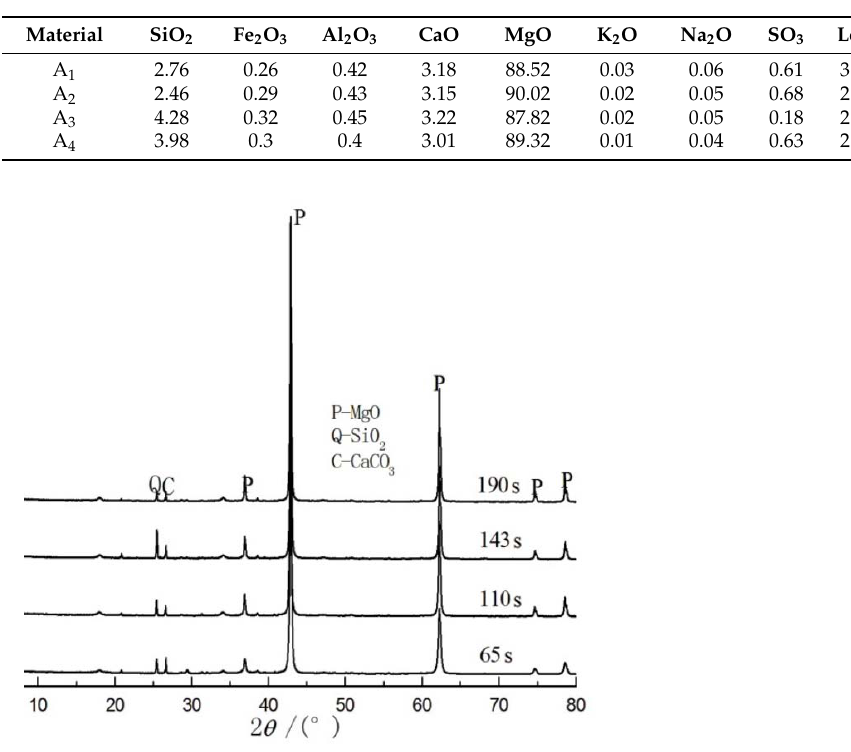
Table 4. The chemical composition of four MgO (wt/%).